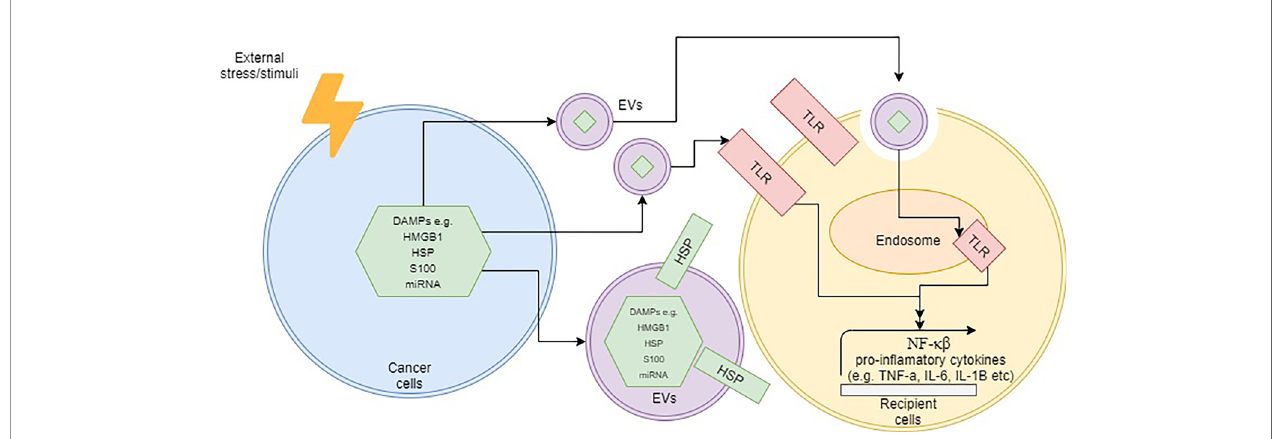
FIGURE 1 | Schematic representation of how DAMP-containing EVs operate upon cellular stress. The localization of DAMPs can be internally or on the surface of EVs. Upon contact with target cells, the TLR pathway may be activated by DAMPs via the surface or endosomal route and subsequently trigger in